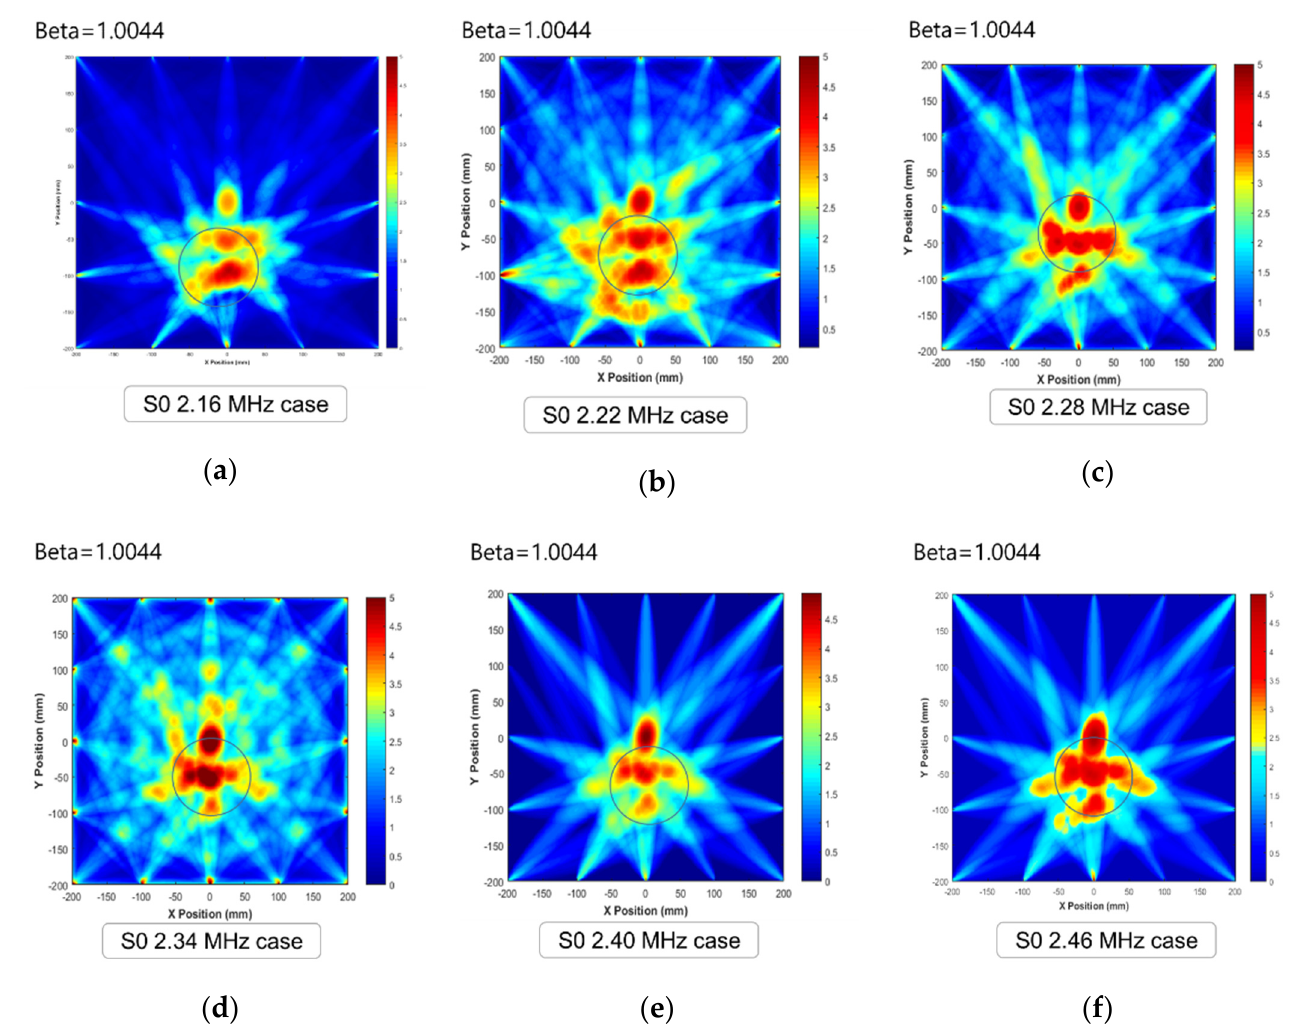
Figure 9. Tomographic images for S0 2.16 to 2.46 MHz·mm: ( a ) S0 2.16 MHz·mm, ( b ) S0 2.22 MHz·mm, ( c ) S0 2.28 MHz·mm, ( d ) S0 2.34 MHz·mm, ( e ) S0 2.40 MHz·mm, and ( f ) S0 2.46 MHz·mm.